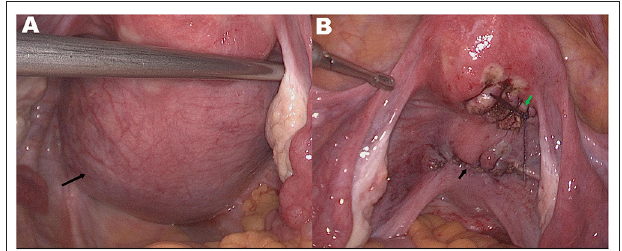
Frontiers in Surgery |